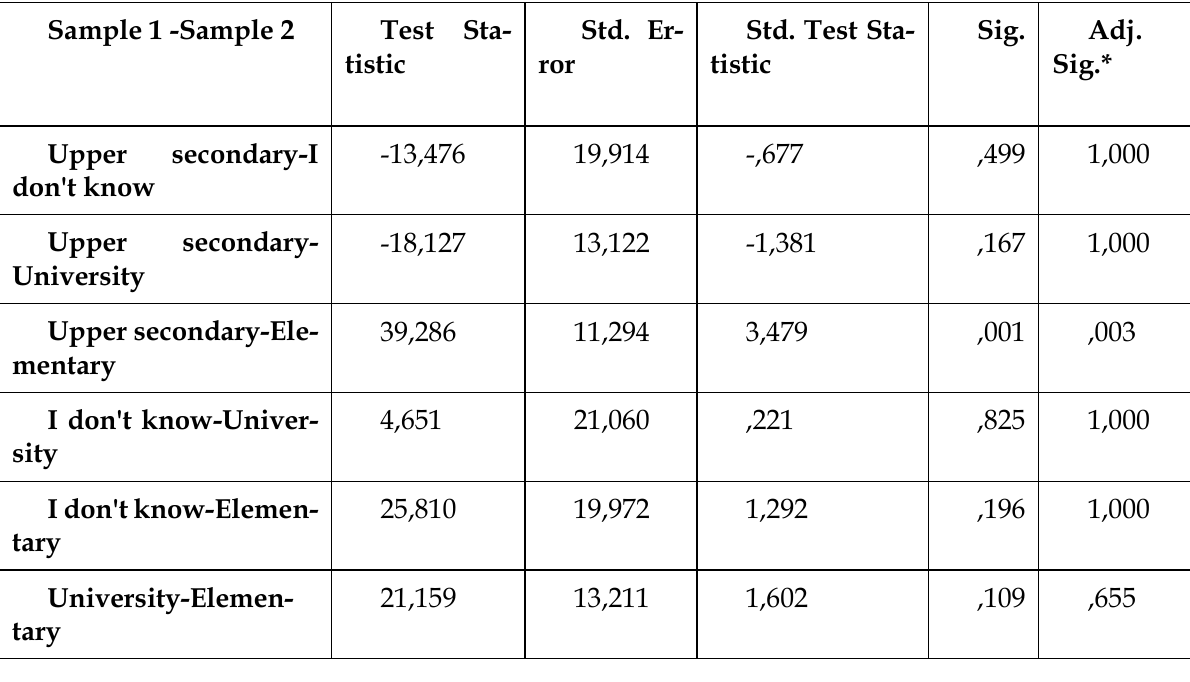
Table 22. Trust towards the health Centre and education. Pairwise comparison (Bonferroni). Each row tests the null hypothesis that the Sample 1 and Sample 2 distributions are the same. Asymptotic significances (2sided tests) are displayed. *Significance values have been adjusted by the Bonferroni correction for multiple